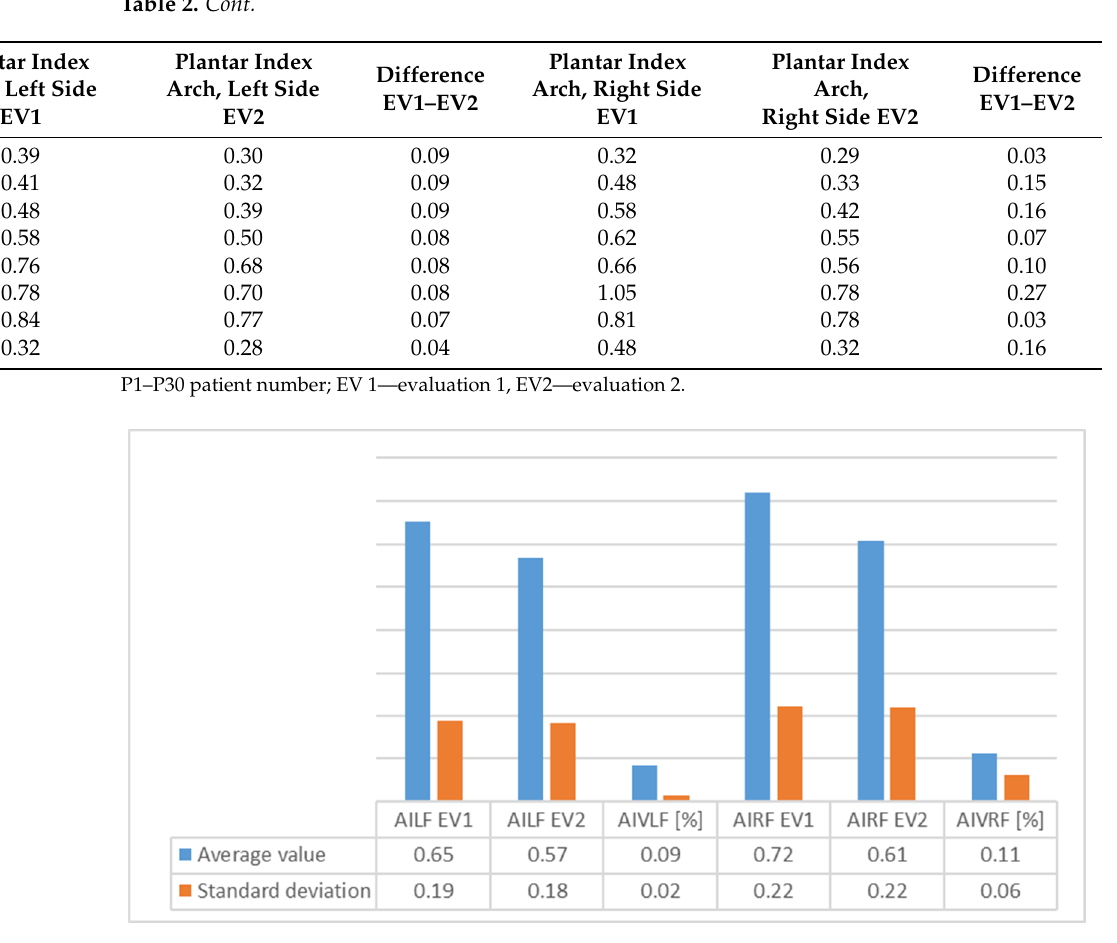
Figure 4. Variation of average values and standard deviation for plantar index arch for Group 1 between EV1 and EV2 (AILF = plantar index arch for left foot; AIVLF = plantar index arch variation for left foot; AIRF = plantar index arch for right foot; AIVRF = plantar index arch variation for right foot).